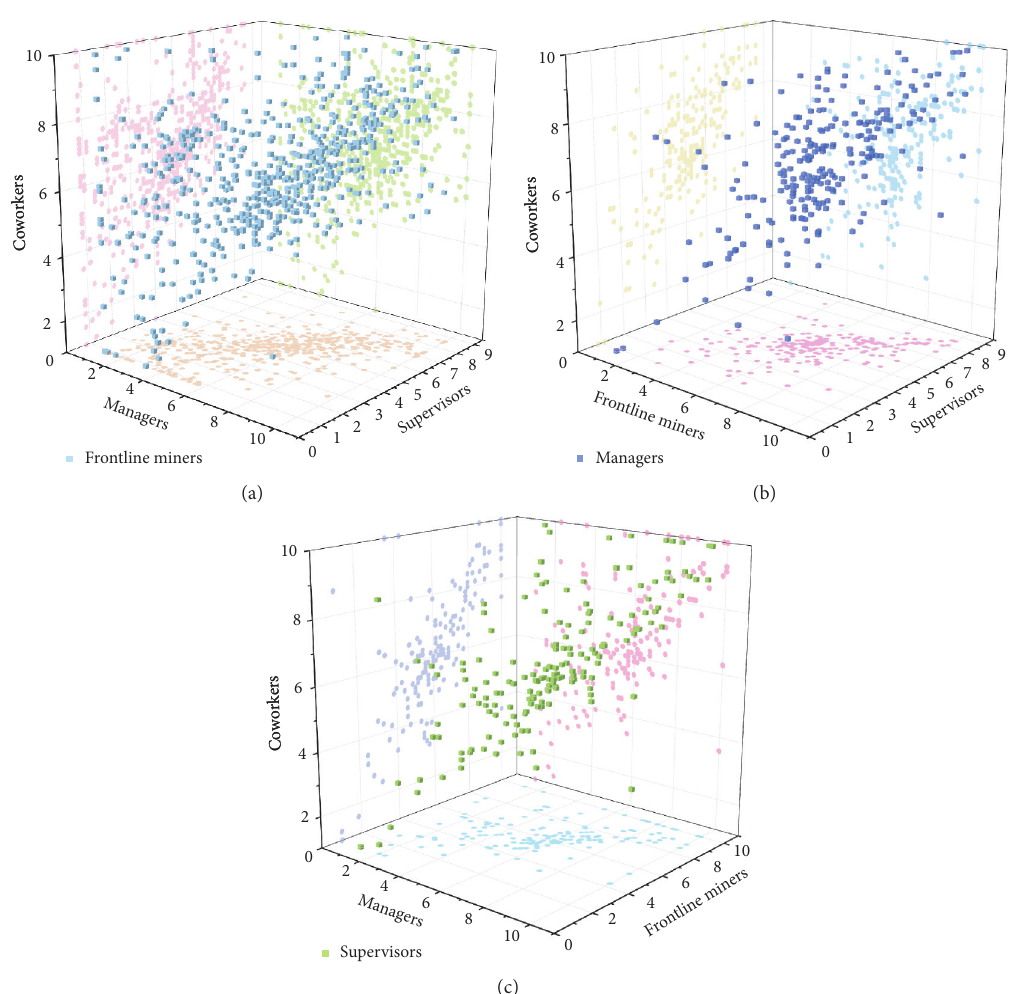
Figure 1: Scatter diagram of relationship perception of (a) frontline miners, (b) managers, and (c) supervisors.